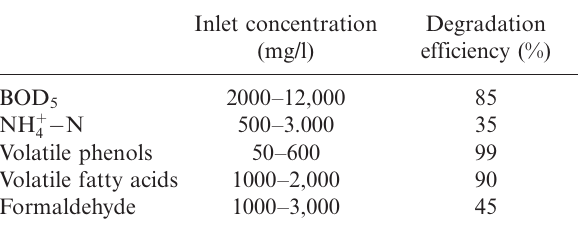
Table 3. Efficiency of the treatment of wastewater from brown coal processing using a bio-tank reactor (Ringpfeil et al. 1988)